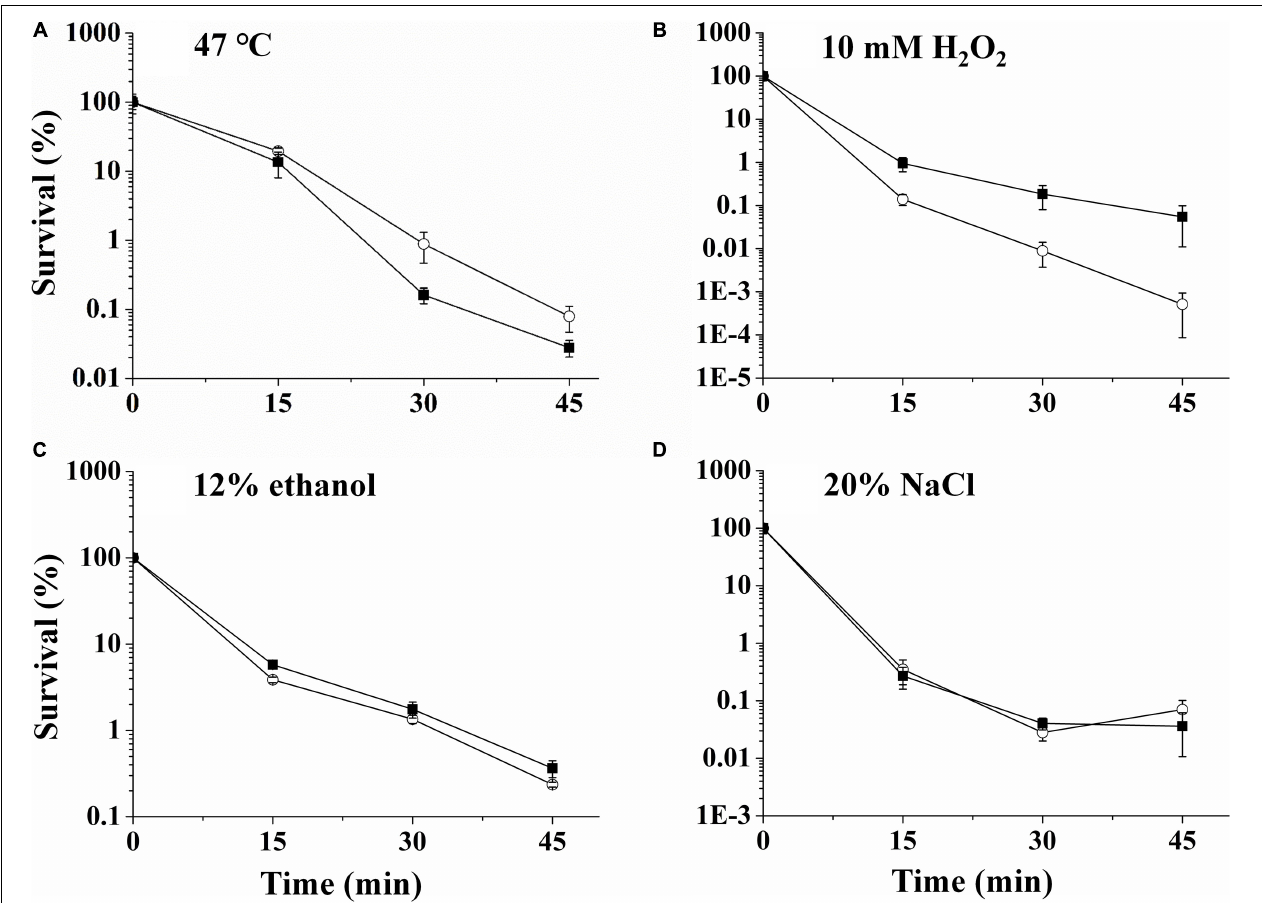
FIGURE 4 | The survival of P. fluorescens wild-type strain UK4 (open circle) and the mutant strain (cid:49) rpoN (closed diamond) after exposure to 47 ◦ C (A) , 10 mM H 2 O 2 (B) , 12% ethanol (C) , and 20% NaCl (D) . Survival percentage was obtained by dividing the surviving population by the initial population, which corresponds to 100%. Data are expressed as mean ± SD of three independent